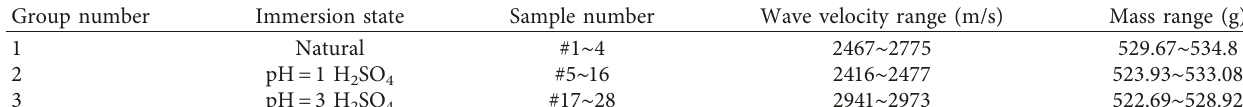
Table 2: Debris components and contents.